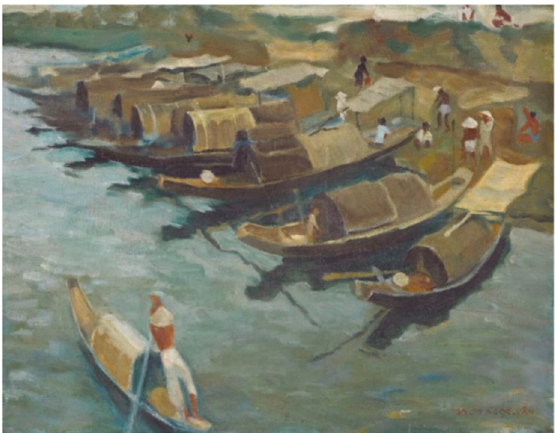
Figure A5. The auctioned Thuyen tren song Huong —To Ngoc Van. Auctioned at Christie’s, May 2016. The image was sourced from website nghethuatxua.vn (Anthony 2016).